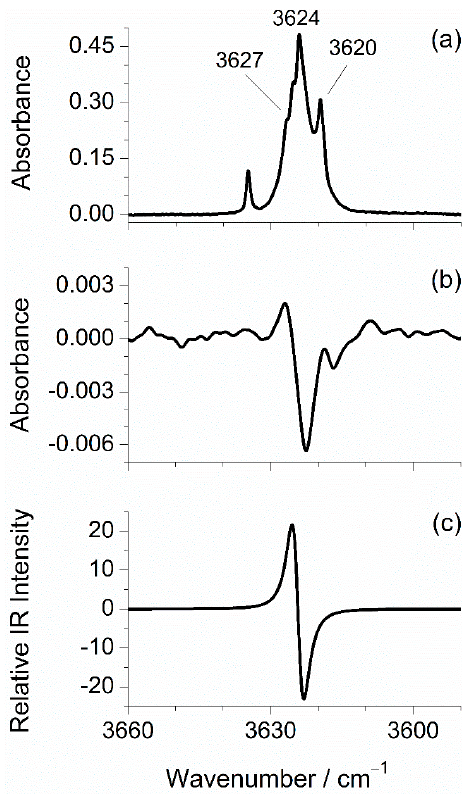
Figure 2. Spectral changes in the OH stretching region induced by broadband IR irradiations of m FP monomers in N 2 matrix. ( a ) IR spectrum recorded immediately after removing the long-pass filter that cuts the IR radiation above ~2200 cm − 1 ; ( b ) Difference spectrum obtained by subtracting the spectrum recorded immediately after removing the filter from that recorded after exposing the matrix-isolated compound to the whole range of broadband IR light emitted from the spectrometer source for 40 min (positive bands correspond to those growing up during exposition of the sample to the unfiltered IR light); ( c ) Simulated B3LYP/aug-cc-pVTZ difference spectrum: cis “minus” trans .